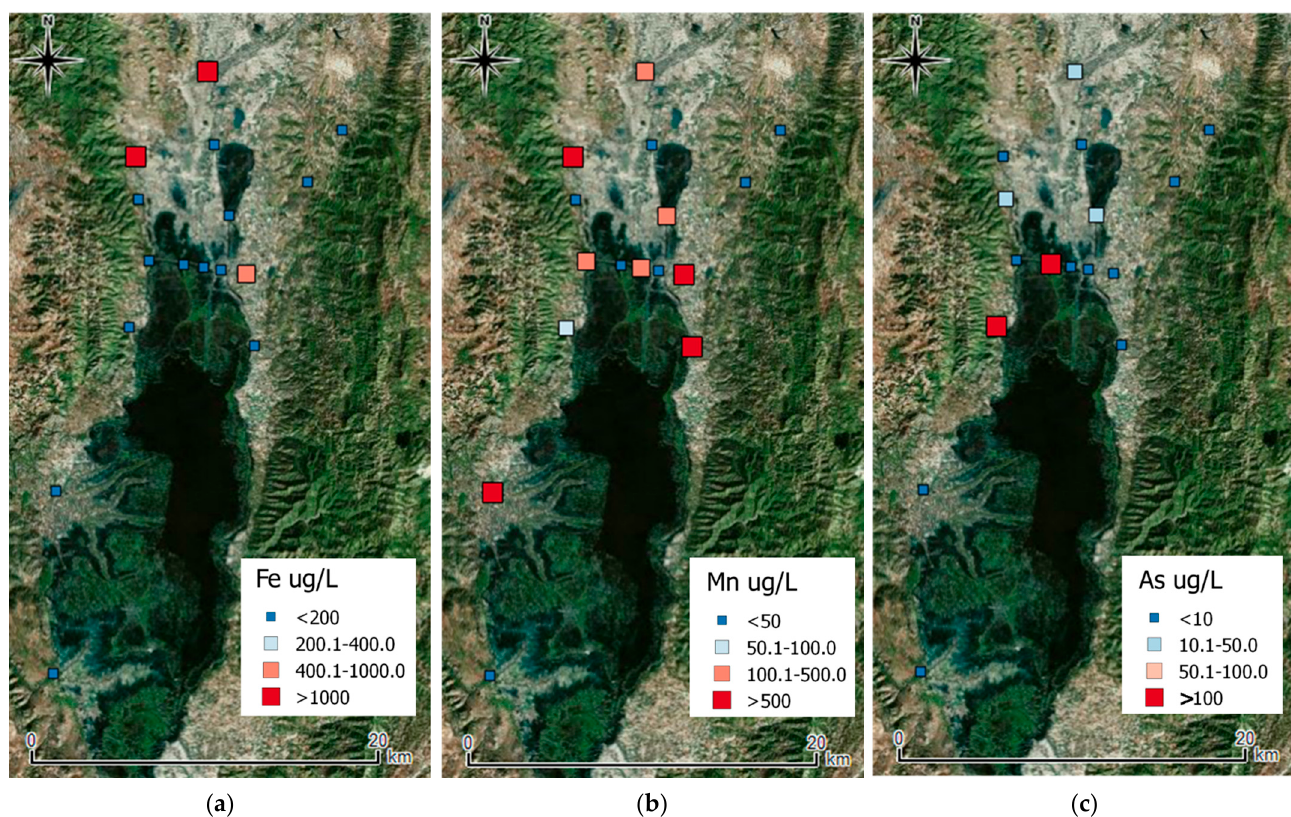
Figure 4. Distribution of trace metals in groundwater from the Inle lake watershed. ( a ) iron; ( b ) manganese; ( c ) arsenic. Only samples indicated with blue squares have concentrations within drinking water standards. Table 1. Average and standard deviation of the isotopic composition and of the d-excess of surface water in the different